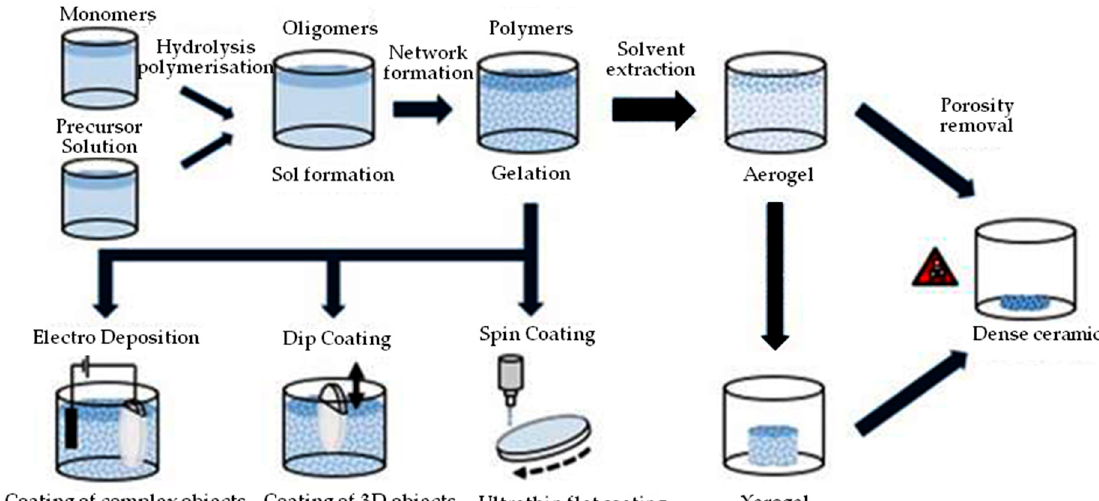
Figure 16. Gel synthesis routes. Processes are defined as sol–gel by the transition of colloidal solution to an interconnected gel network (gelation). The further processing stages illustrated are non-redundant and may be combined depending on the specific needs of the application [96]. 3D: three-dimensional. Reprinted with permission from reference [96] 2016 Elsevier.